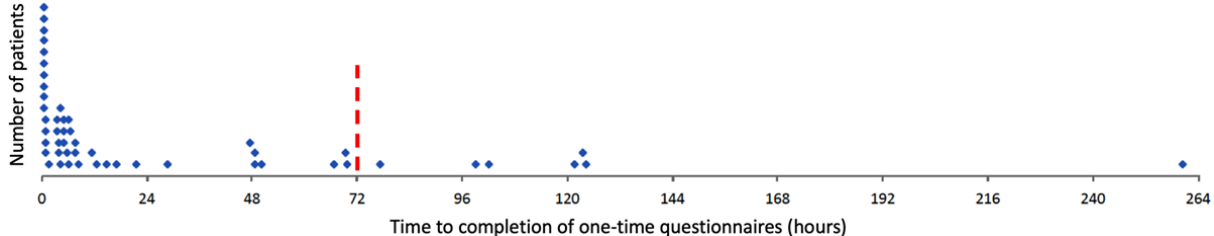
Figure 6. Time to completion of one-time questionnaires (expressed in hours). Patients (indicated by blue rhombuses) were asked to answer all one-time questions within 3 days of enrollment (indicated by the dashed vertical red